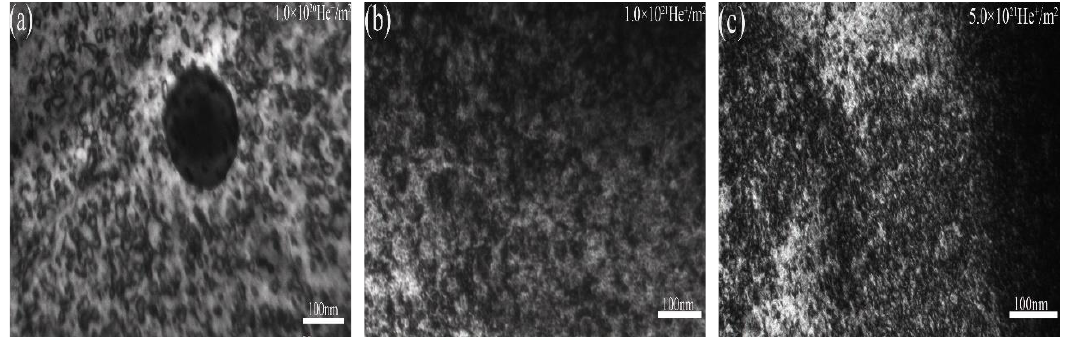
Figure 7. TEM images showing the microstructural evolution in W-1wt%TiC exposed to 5 keV He + as a function of fluence: ( a ) 1.0 × 10 20 He + /m 2 ; ( b ) 1.0 × 10 21 He + /m 2 ; ( c ) 5.0 × 10 21 He + /m 2 .